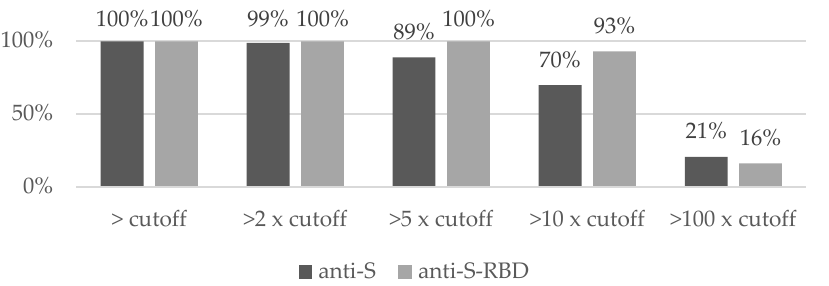
Figure 1. The proportion of vaccinated participants with anti-S and anti-S-RBD antibody levels greater than multiples of the cut-off determined the positive result.